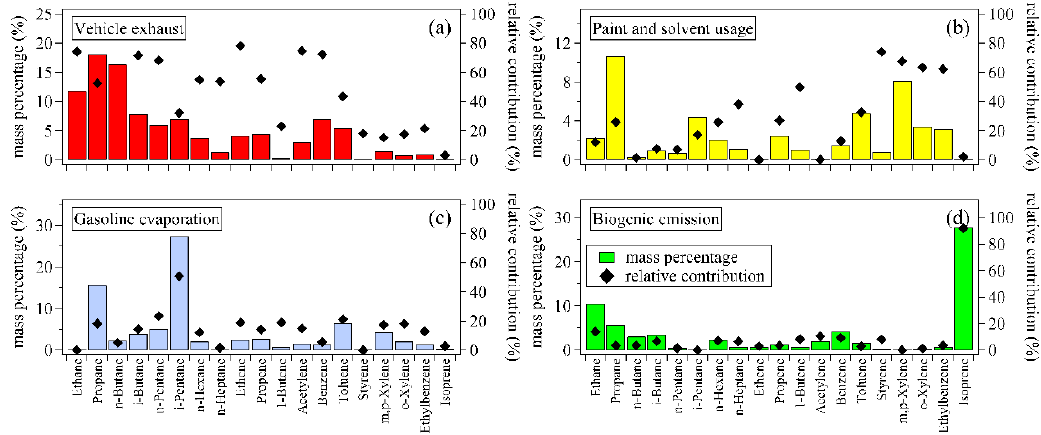
Figure 8. Chemical profiles of 4 factors resolved by the positive matrix factorization (PMF) model. ( a ) vehicle exhaust (red), ( b ) paint and solvent usage (yellow), ( c ) gasoline evaporation (blue), and ( d ) biogenic emission (green). The bars mean percentages of individual species in the summed mass concentrations of 19 NMHCs for each factor. The filled diamonds represent the relative contributions of each factor to the total measured mass concentrations for individual NMHC species.